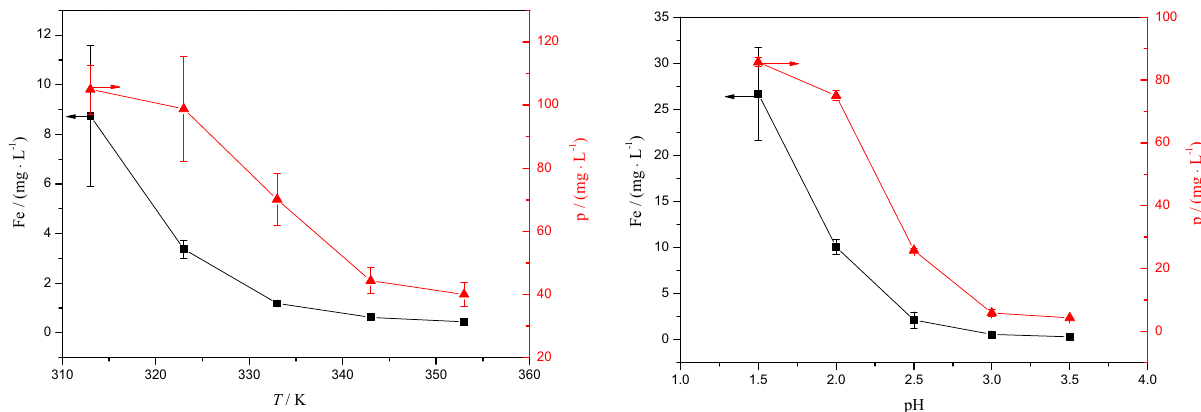
Figure 4: Content of iron and phosphorus in the fi ltrate at di ff erent reaction temperature. n P/ n Fe = 6.0, t = 60 min, pH = 2.0.